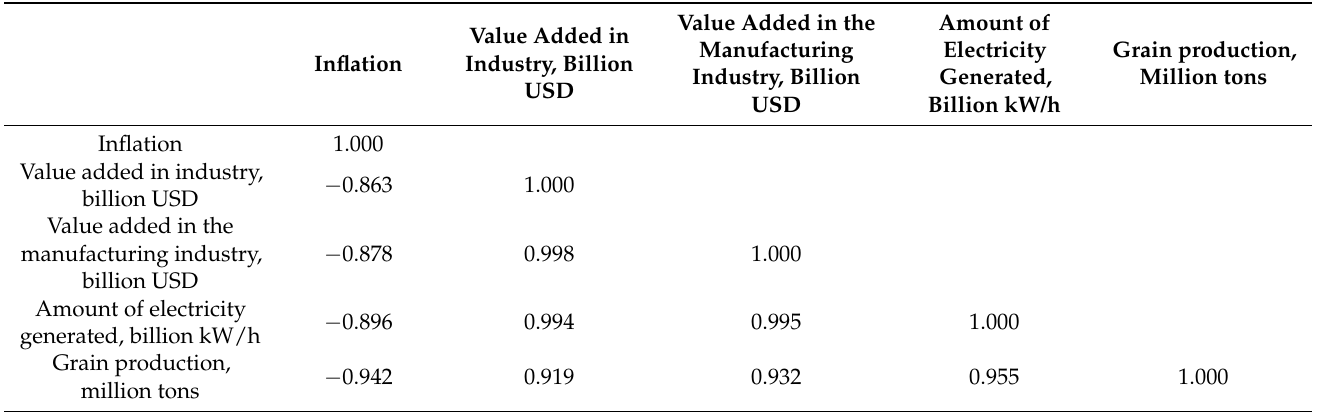
Table 8. Results of correlation analysis of inflation and industrial integration factors.